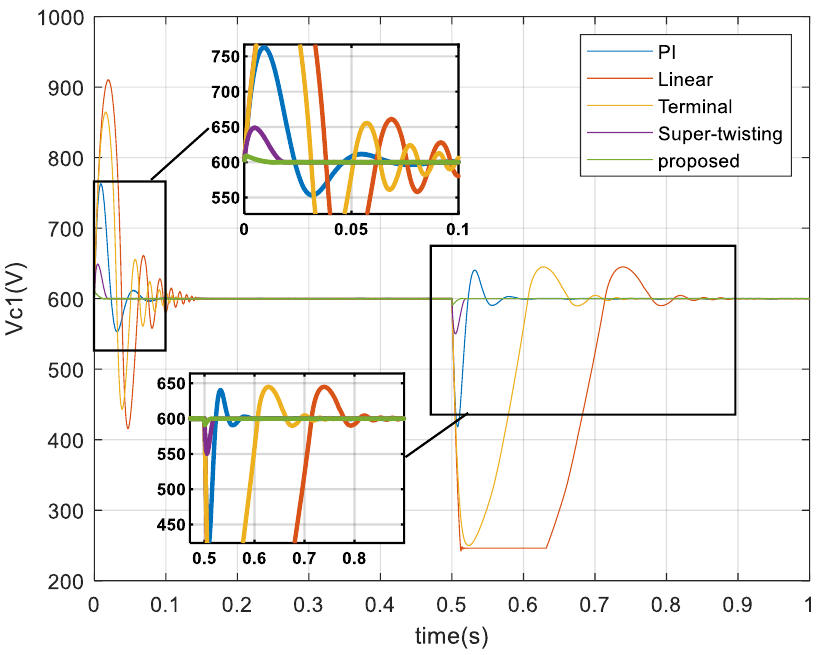
Figure 15. Comparison of high-order sliding mode controllers with other controllers.